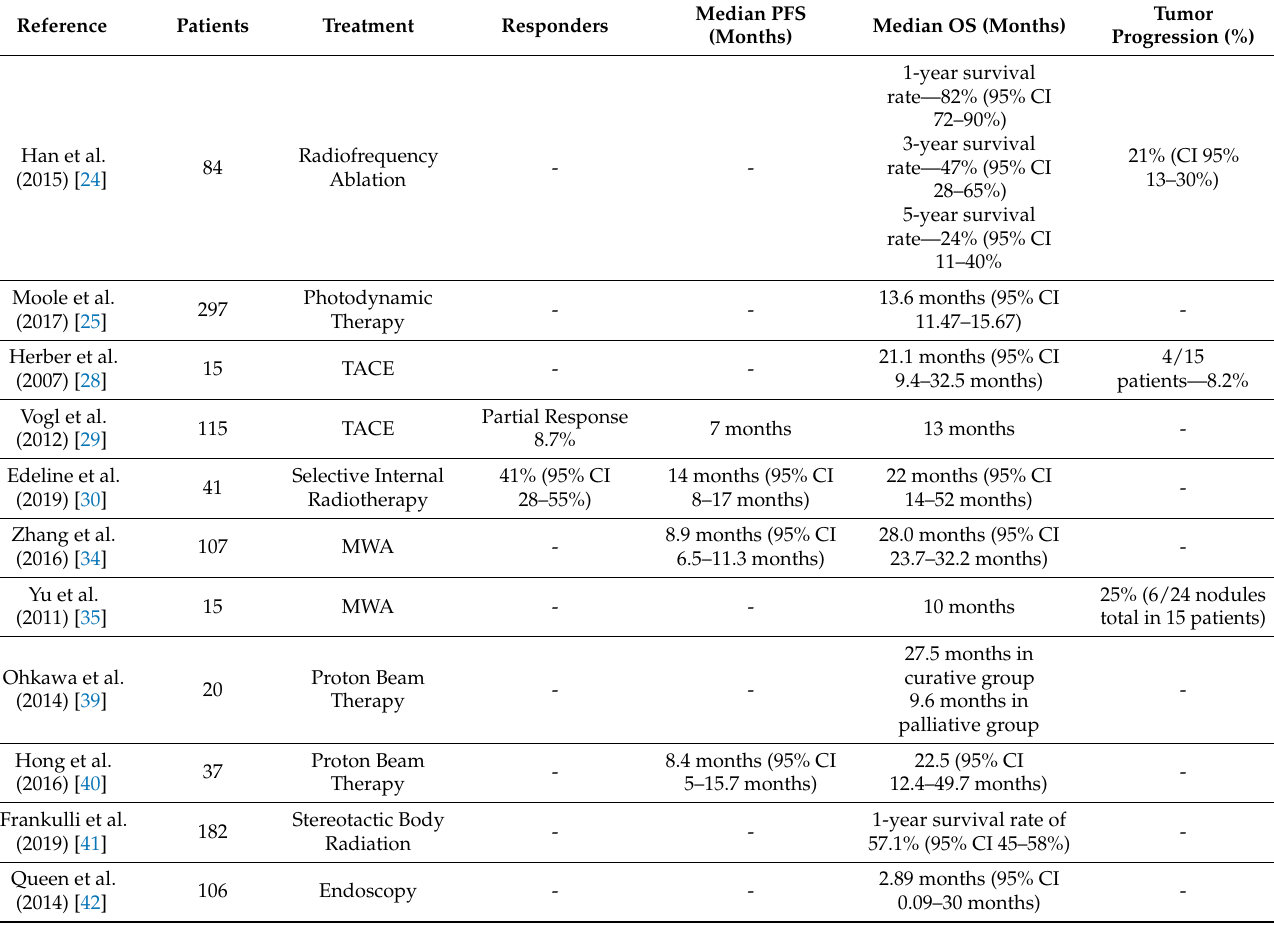
Table 1. Summary of studies on the use of locoregional therapy for